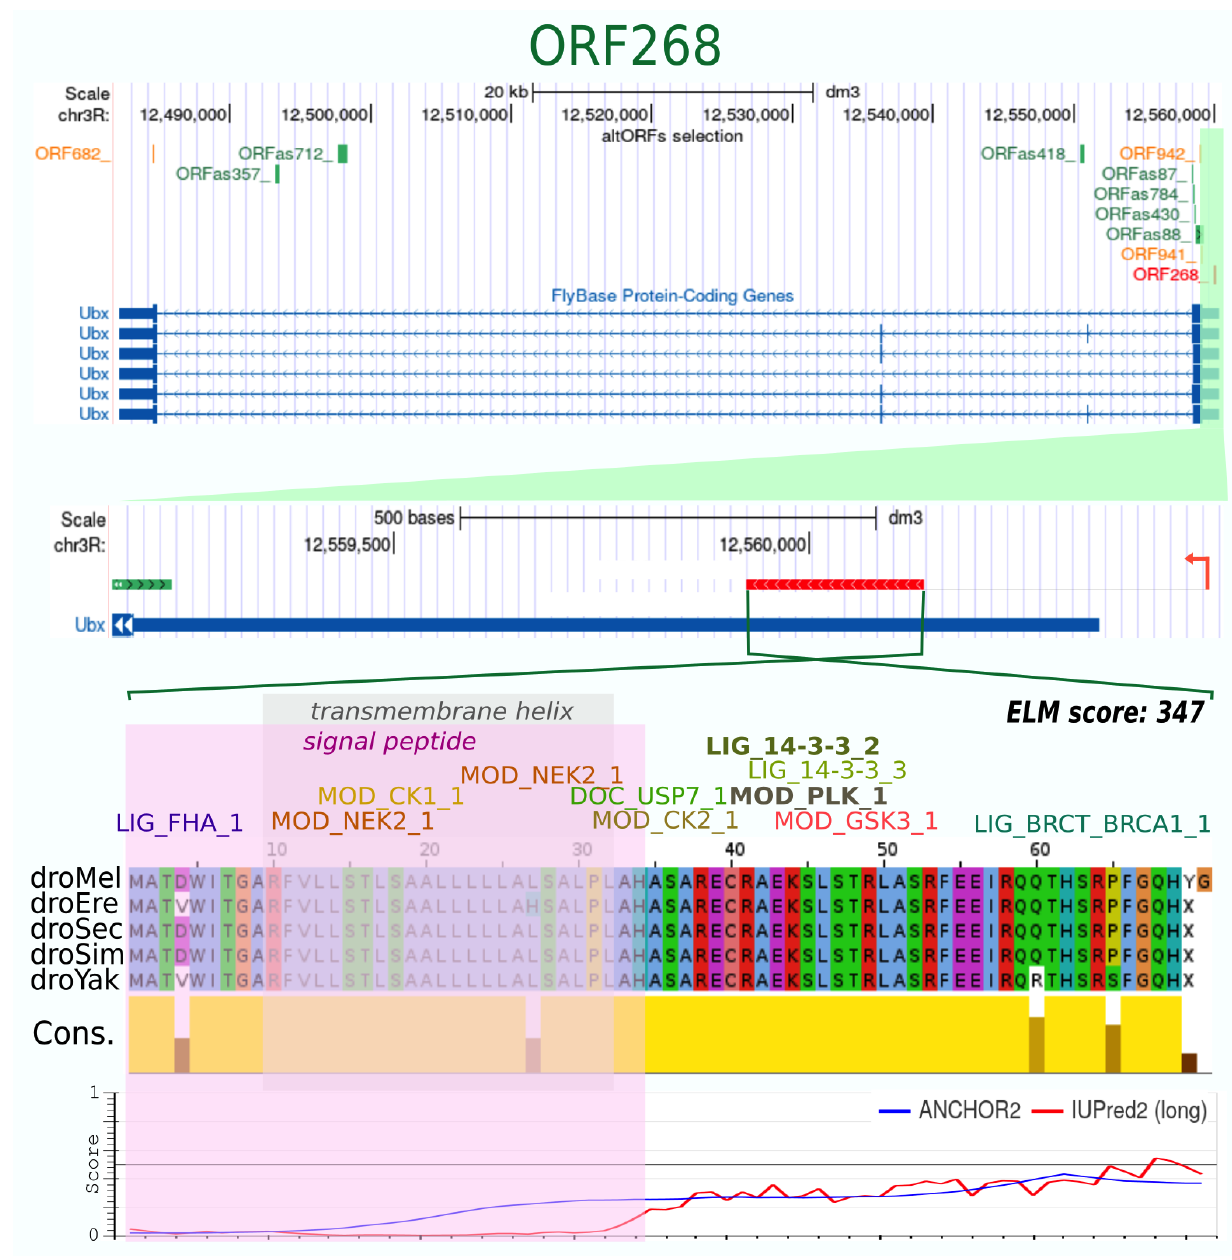
(cid:48) UTR of Ubx , in the same orientation. The putative Figure 3 Figure 3. Characterization of the ORF268. This altORF is in the 5 promoter is indicated (red arrow). It is found in 5 species and is highly conserved (yellow graph below the protein sequence alignment). The 71 aas long peptide is globally ordered. It contains a signal peptide and a transmembrane helix (pink and gray shadows, respectively), as well as several ELMs of different types. This altORF has previously been described in a pioneer study of the Ubx genomic region